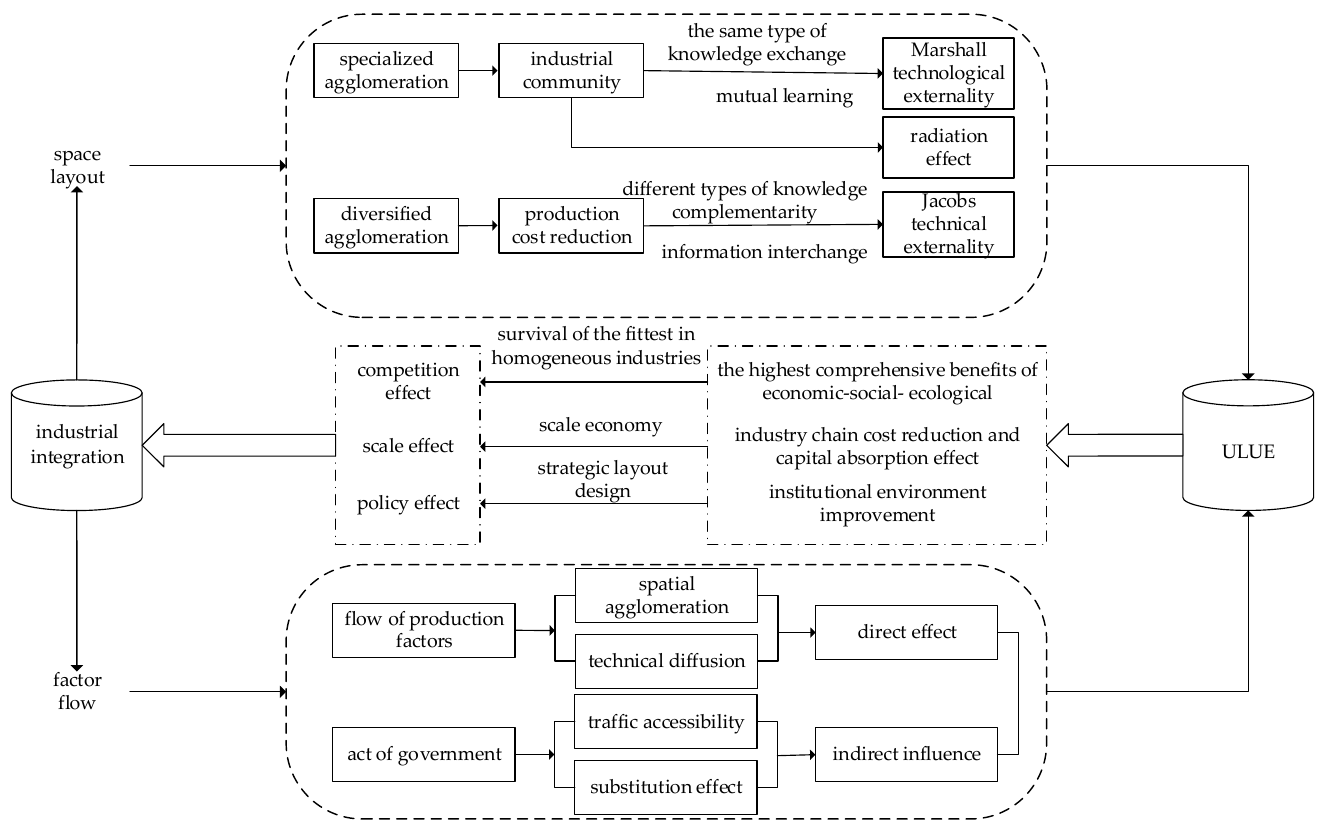
Figure 1. The coupling coordination mechanism between industrial integration and ULUE.